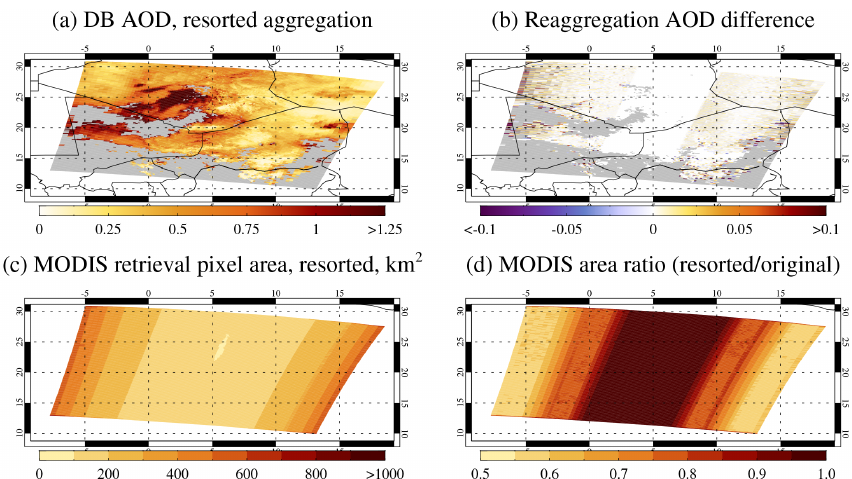
Figure 8. DB AOD retrieval for the granule in Fig. 2 using the “resorted” aggregation technique. Panel (a) shows the DB AOD at 550nm, (b) the difference from the AOD using the standard aggregation technique (Fig. 2c), (c) the resulting retrieval-pixel area, and (d) the ratio of the area using the resorted technique to that from the standard technique (i.e. ratio of panel (c) to Fig. 2d). Pixels without retrievals are shaded in